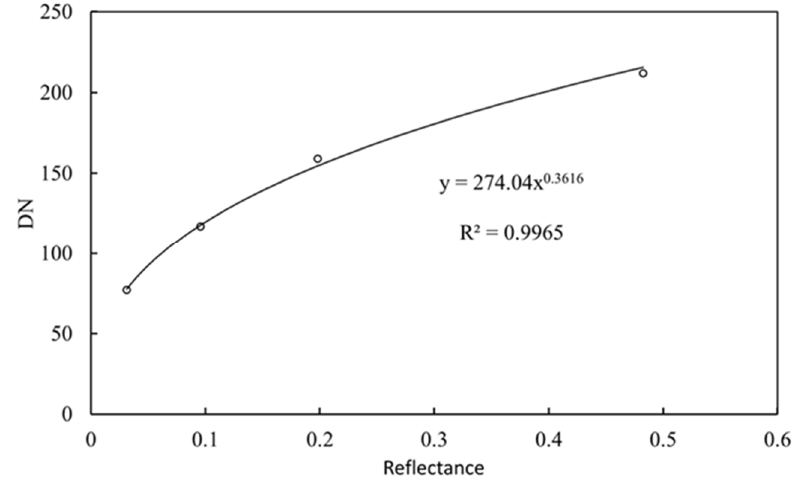
Figure 3. Scatterplot and fitting line of reflectance of the four reference cards and corresponding digital pixel numbers (DNs) in the red band. The relationship between the DNs and their equivalent reflectance is nonlinear, and the R 2 fitted by power function reaches 0.9965.